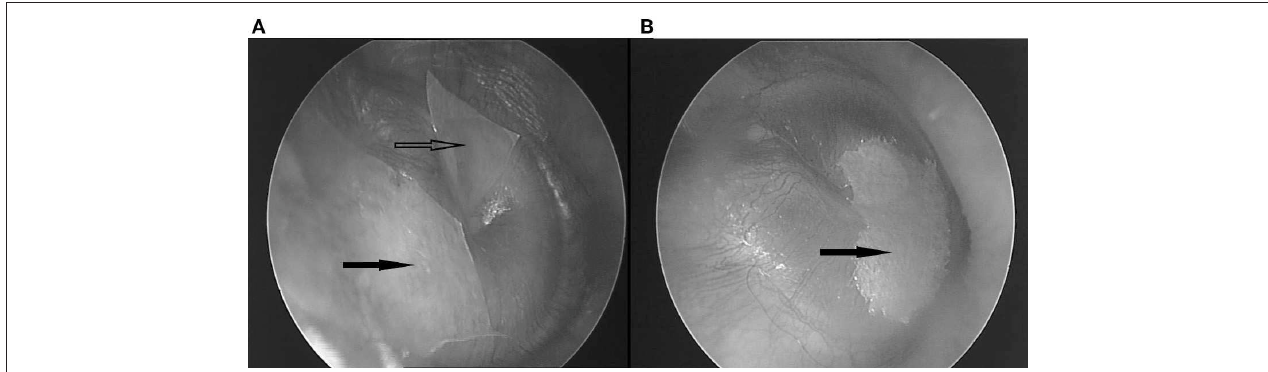
FIGURE 1 | (A) Two patches covering the superior half. Hollow arrow: anterosuperior patch; black arrow: posterosuperior patch. (B) One bigger patch, covering the inferior half. Black arrow: inferior patch.